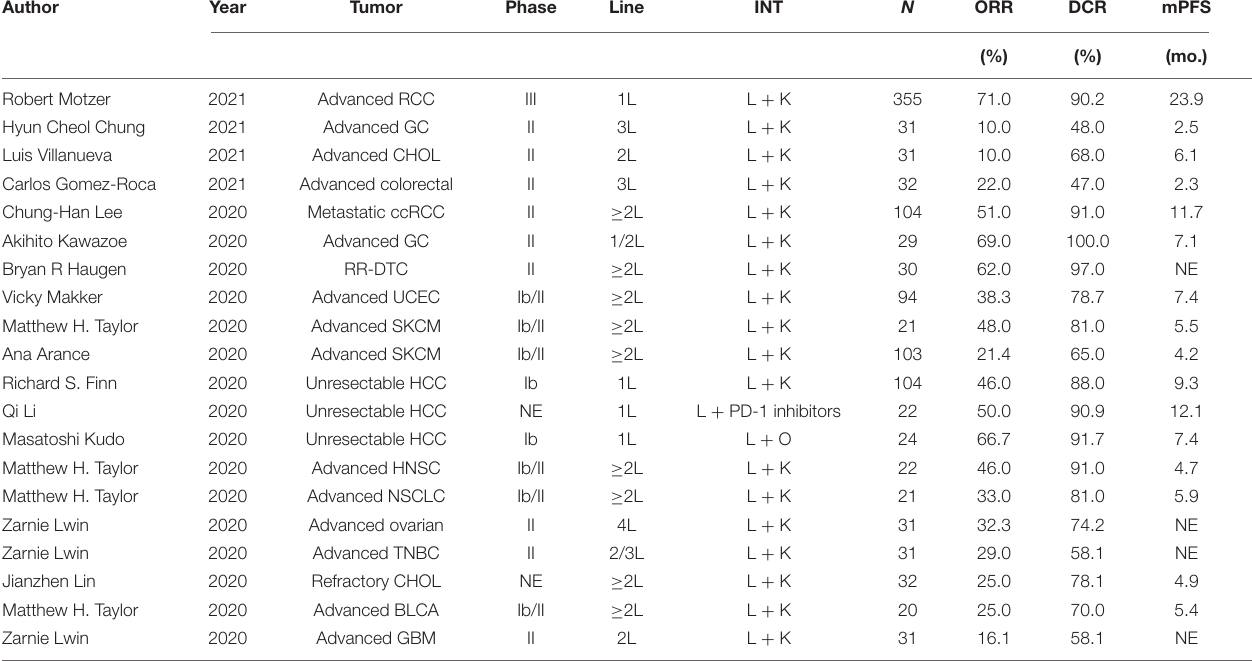
TABLE 1 | Main characteristics of the studies included in the